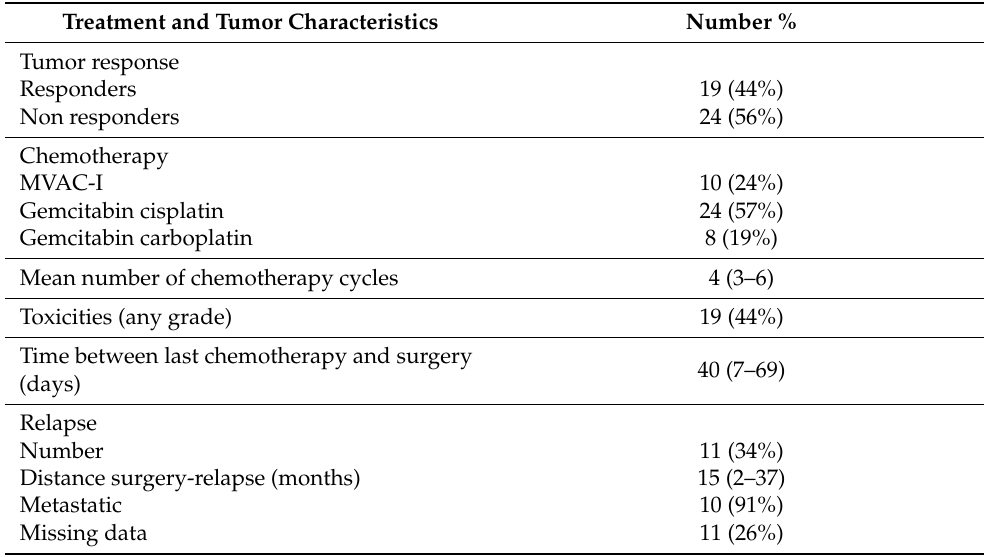
Table 2. Tumor and treatment